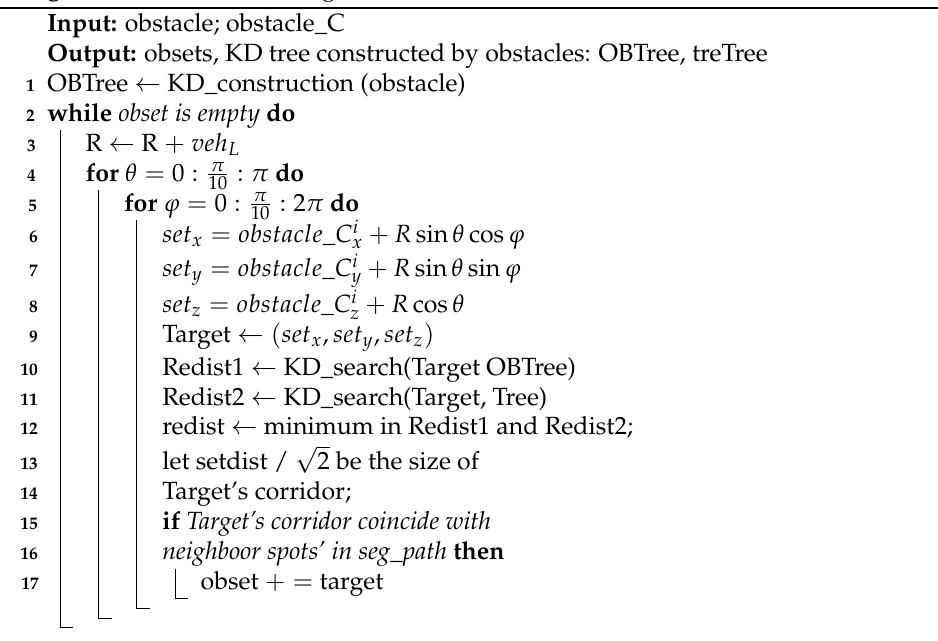
Algorithm 4: Reconstructing a KD tree for each